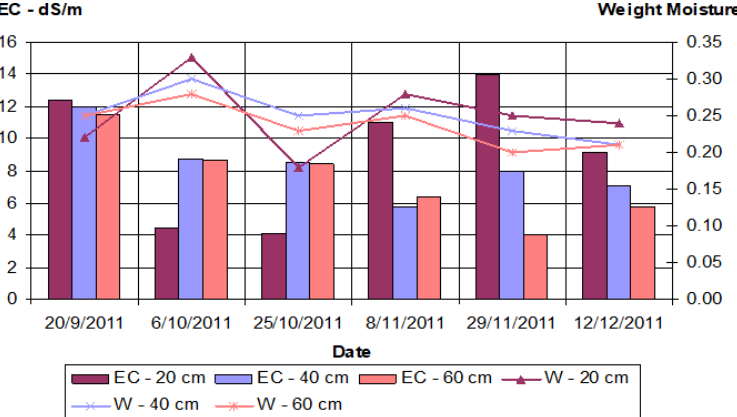
Figure 6. Changes in soil salinity (EC) and soil weight moisture (W) during the autumn near the first tensiometer station.